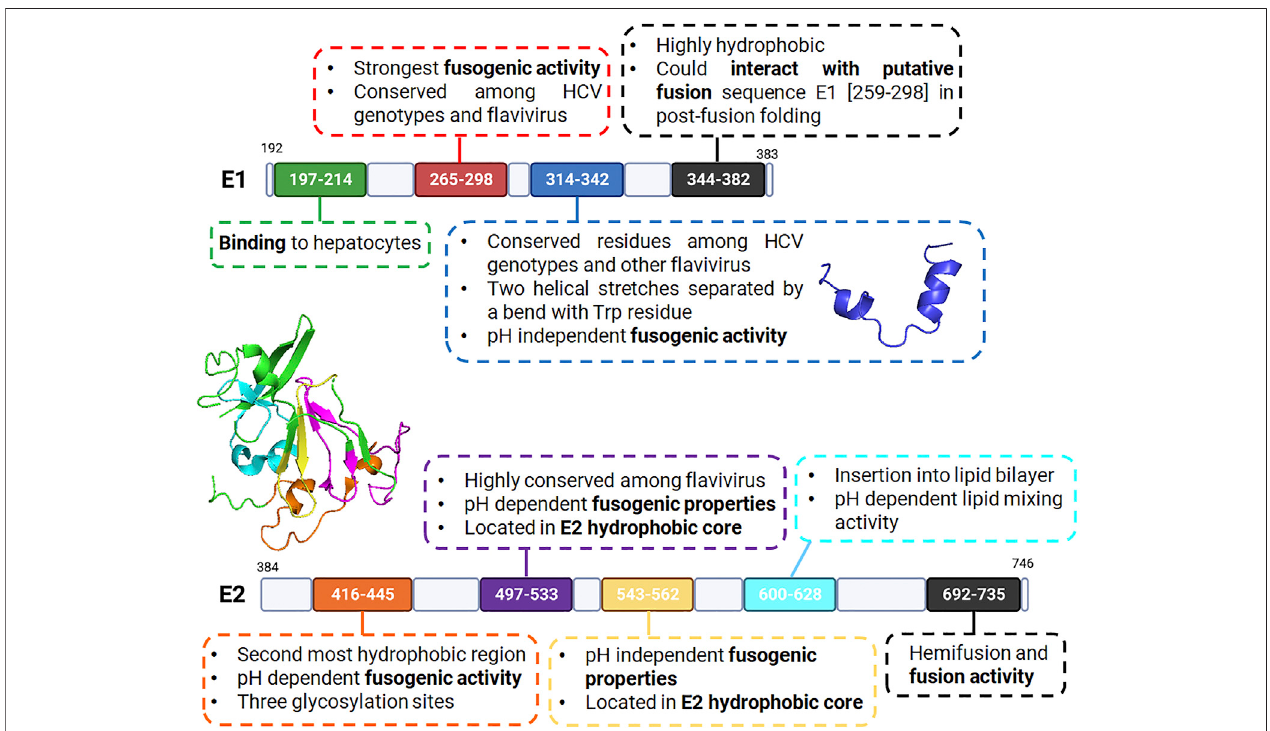
FIGURE8| SchematicrepresentationofHCVE1and E2fusionproteinswithselectedmembrane activesequences,andtheircorrespondingpropertiesaccording to literature. Upper panel: HCV E1 protein with N -terminal domain (green), putative fusion peptide (red), pre-transmembrane domain (blue) and its structure determined by Spadaccini et al. (PDB code 2KNU) and C -terminal region including the transmembrane domain (black). Lower panel: HCV E2 protein and its partial ectodomain structure (determined by Kong et al. (Kong et al., 2013), PDB code 4MWF) with N -terminal domain fl anked by hypervariable regions (orange), hydrophobic core region (purple and gold), pre-transmembrane domain (cyan) and C -terminal region transmembrane domain (black).